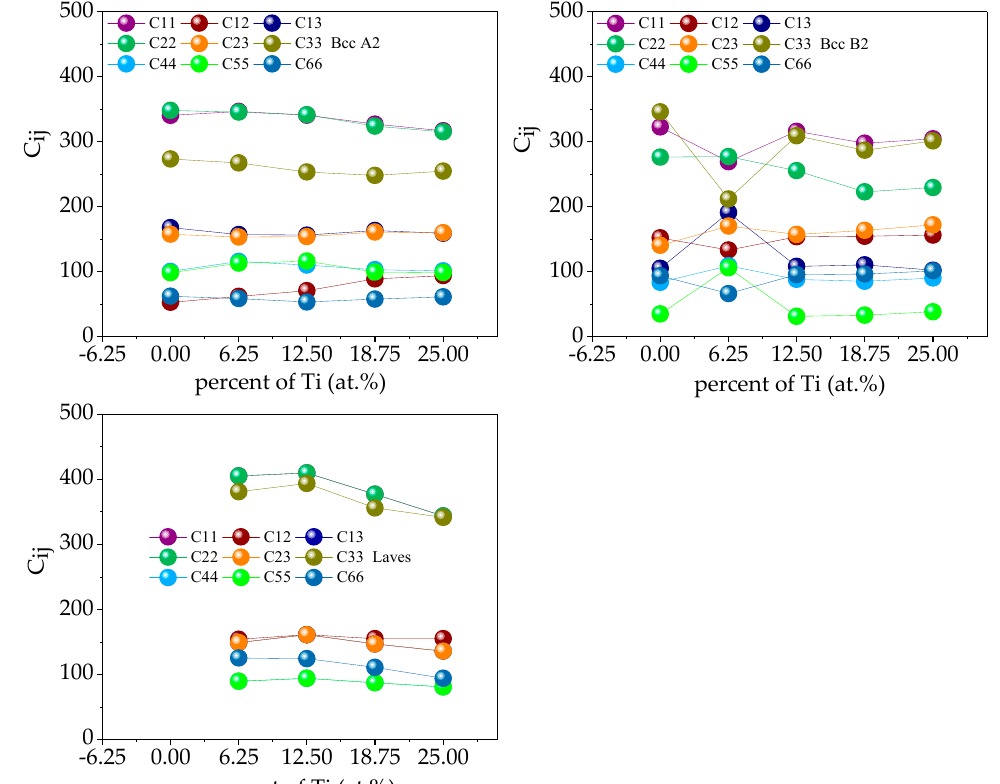
Figure 13. The calculated elastic constants ( C ij ) for single-phase Fe 25 Cr 25 Ni 25 Ti x Al (25 − x) .